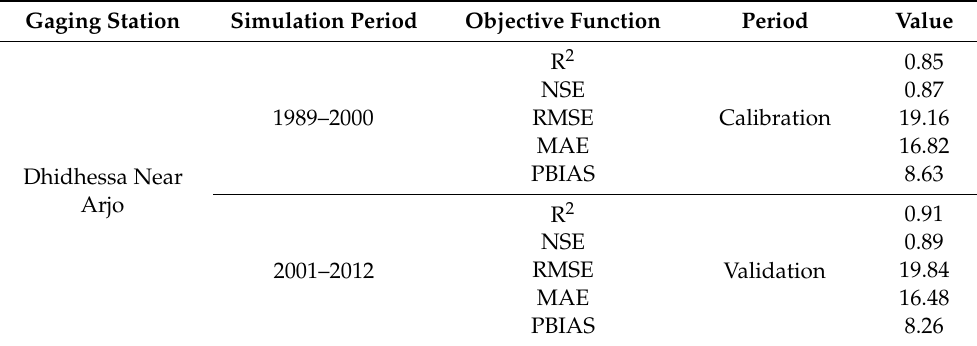
Table 3. Model goodness-of-fit statistics for the calibration and validation periods.